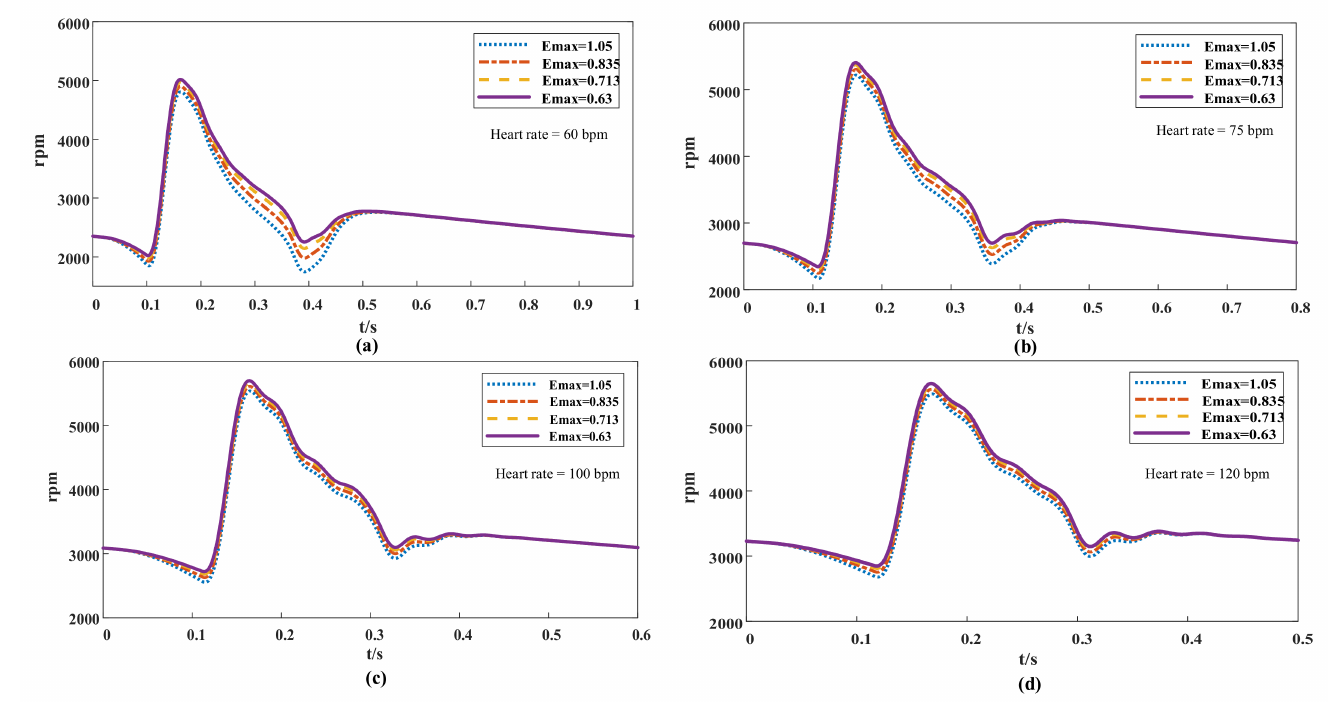
Figure 6. Variable-speed image under different E max in a cardiac cycle at different heart rates. ( a ) heart rate = 60 bpm, ( b ) heart rate = 75 bpm, ( c ) heart rate = 100 bpm, ( d ) heart rate = 120